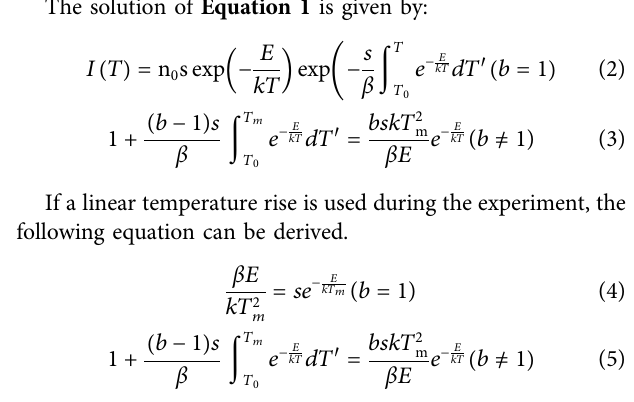
FIGURE 1 | Schematic of TSDC program on epoxy/rubber composite.